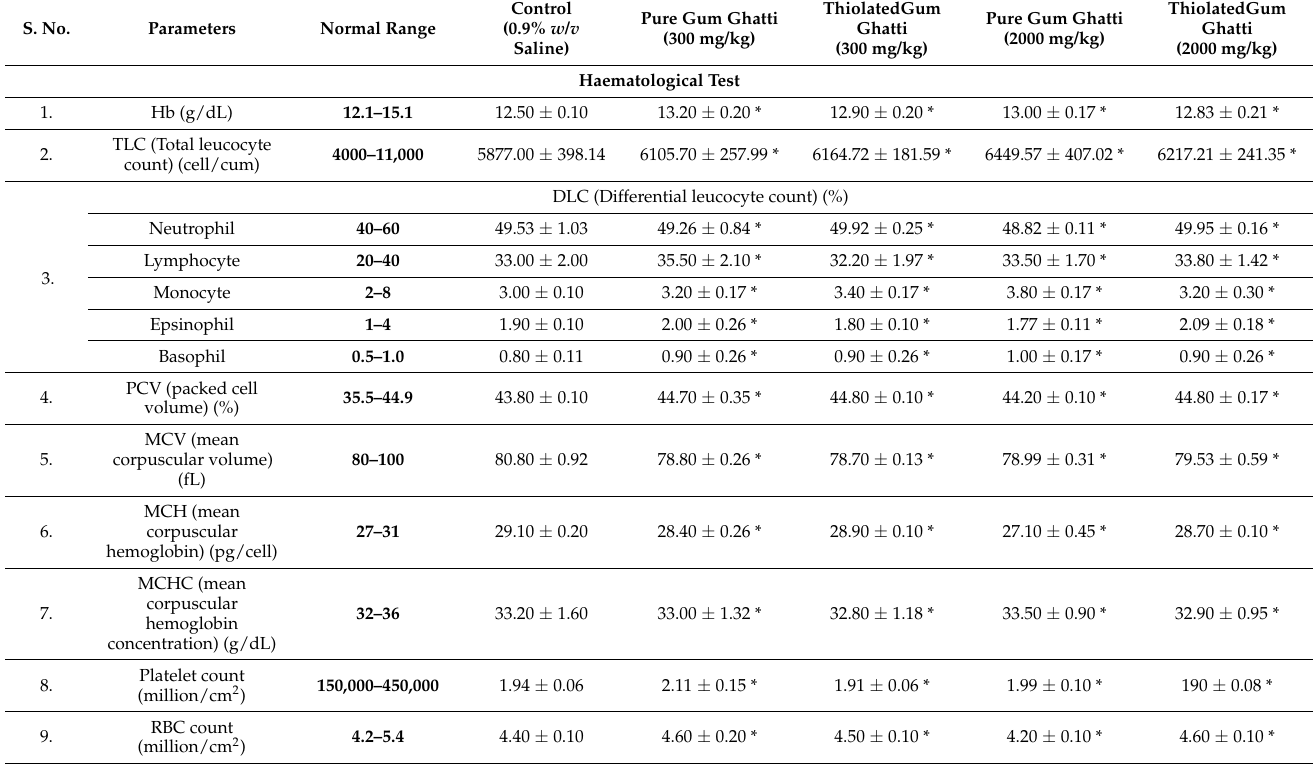
Table 2. Single dose comparative analysis of acute oral toxicity showing the effect of gum ghatti and thiolated gum ghatti on hematological parameters, liver profiles, kidney profiles, and feeding behaviors, after testing in experimental Wistar